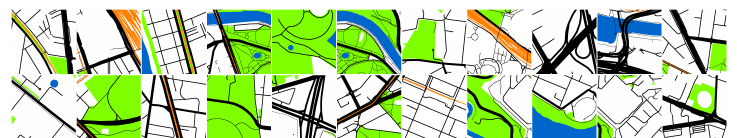
Figure 6. Gallery of “Paris-like” locations in Melbourne using the GM neural network.